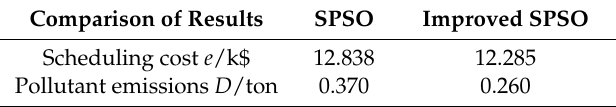
Figure 14. The change curve of pollutant emissions with the number of iterations (improved SPSO). Table 12. Comparison of two algorithm scheduling results.